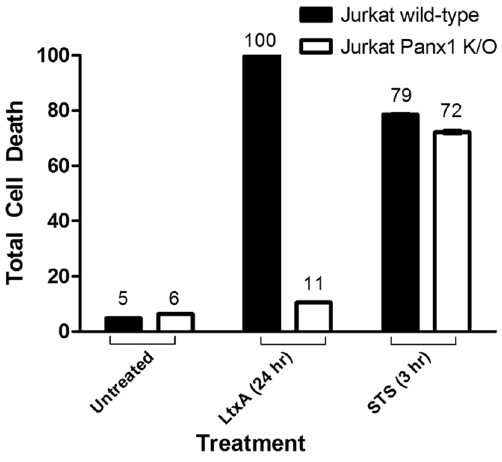
Figure 6. Panx1 K/O cells have reduced sensitivity to LtxA at concentrations of 0.3 µg/mL for as long as 24 h. Jurkat wild-type and Panx1 K/O cells were treated with LtxA for 24 h. Following treatment, Jurkat wild-type cells stained over 100% positive for Annexin while Panx1 K/O cells showed Annexin staining similar to that of untreated control cells. To assess whether the appropriate apoptotic machinery was functioning properly in Panx1 K/O cells, STS was used as a positive control. Both Jurkat wild-type and Panx1 K/O cells showed similar Annexin staining patterns following treatment with STS. Where indicated, cells were treated with LtxA at a concentration of 0.3 µg/mL for 24 h or with staurosporin (STS) at a concentration of 1 µM for 3